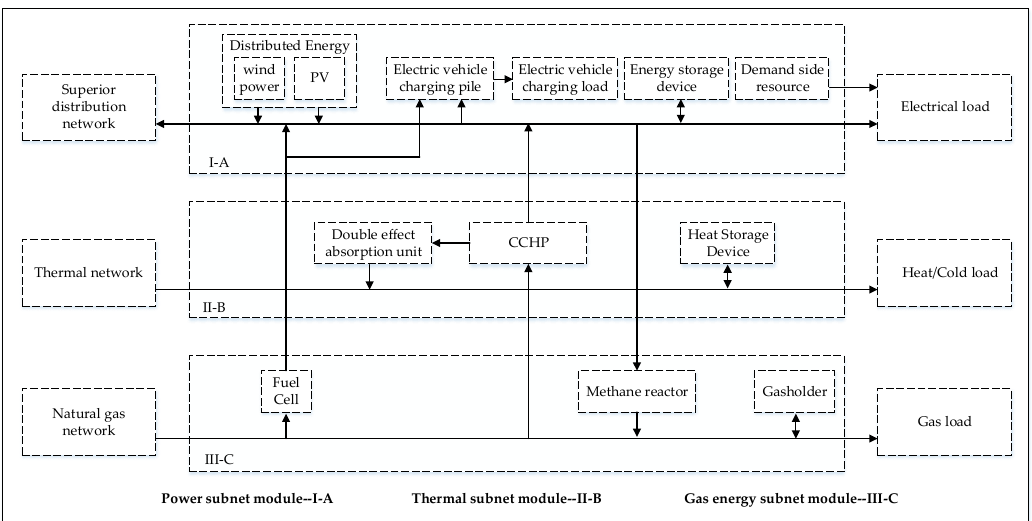
Figure 1. Basic component module and energy flow relation between energy subgrids in micro-energy Internet.